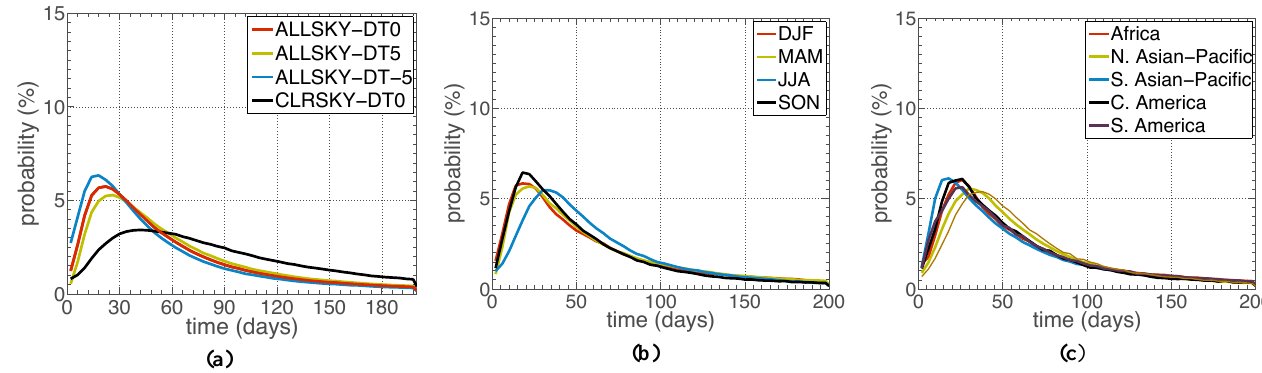
Fig. 10. (a) Ensemble, (b) seasonal and (c) regional histograms of transit-times between detrainment and launch at the 100hPa surface. Also shown in (c) the corresponding histogram for those trajectories detrained over the land part of the north Asian-Pacific region (brown line). Results obtained from the CS-TTL trajectory ensemble ALLSKY- 1T 0. The histograms are calculated using a bin size of 4